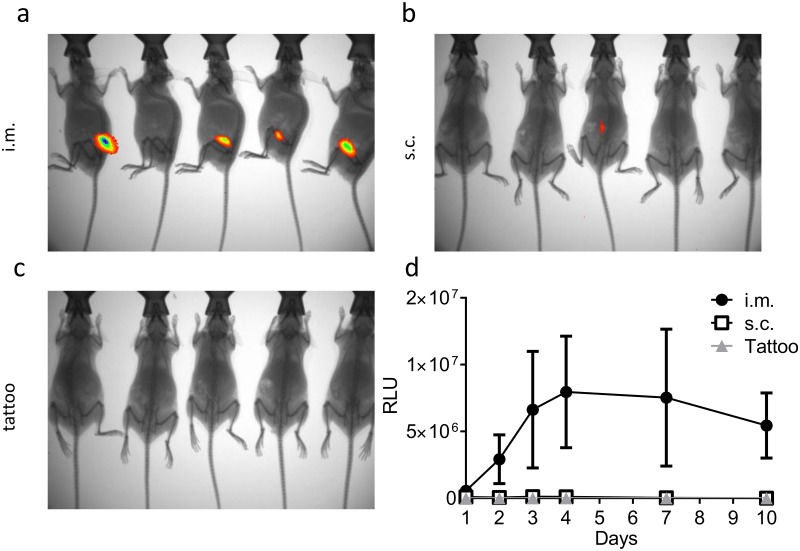
Comparison of luciferase expression after DNA by various routes.50μg DNA encoding luciferase was delivered by the i.m., s.c. or tattooing routes. At various time points after transfection, mice were injected i.p. with Luciferin substrate and imaged in vivo using an Imaging System. Representative images from day 7 after transfection by the i.m. (a), s.c. (b) and tattoo (c) routes. Relative expression levels were quantified using image analysis software (d), points represent mean +/- SEM of n = 5 animals.